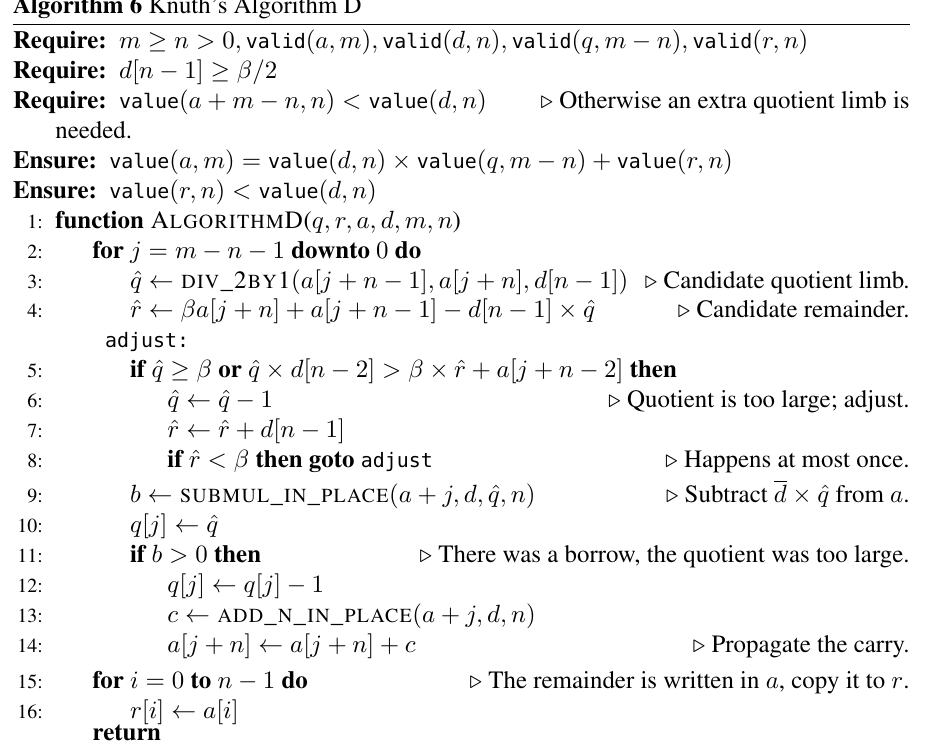
Algorithm 6 Knuth’s Algorithm